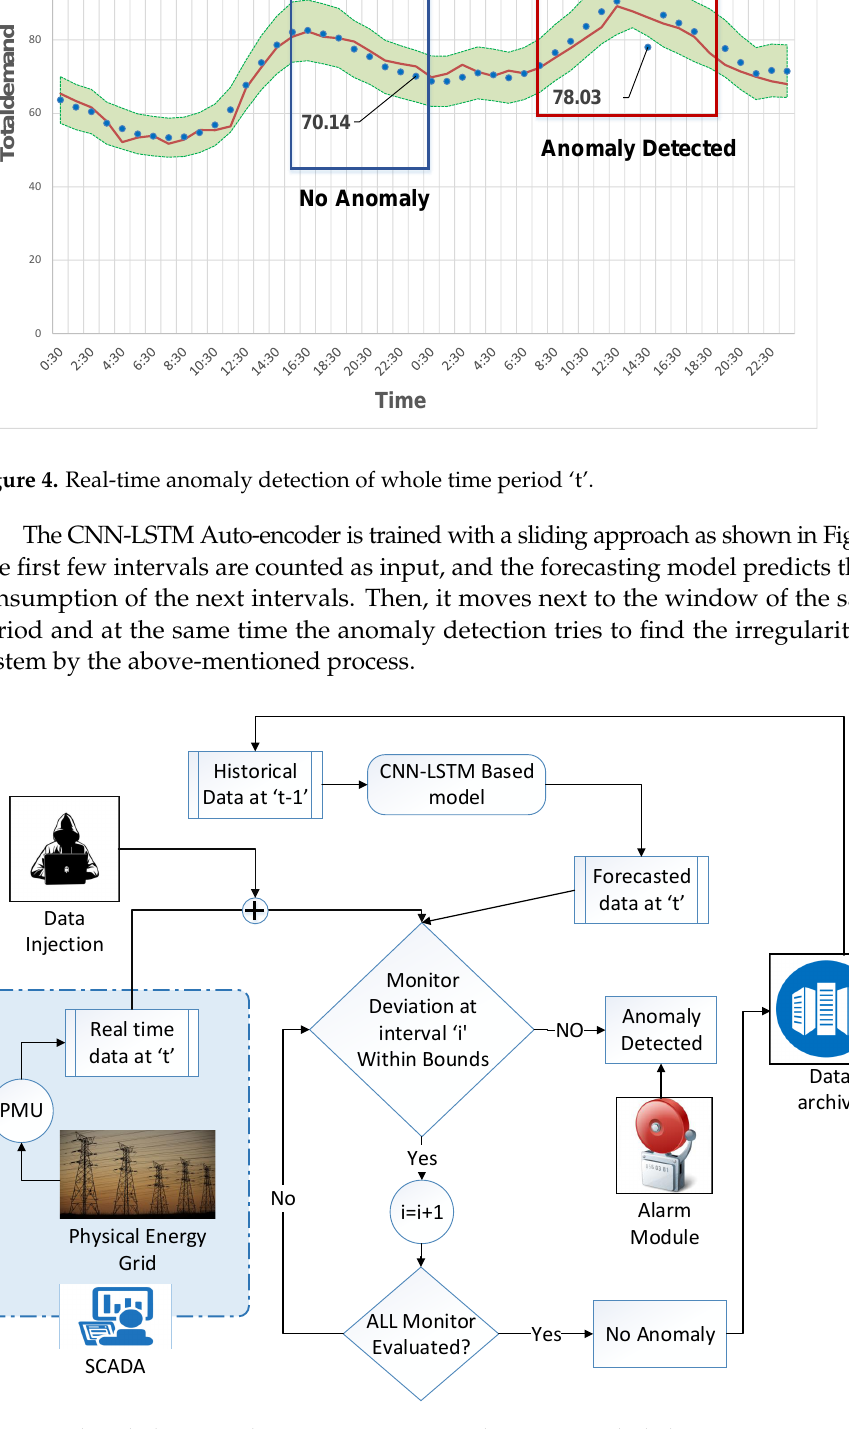
Figure 5. The whole Anomaly Detection Engine with SCADA